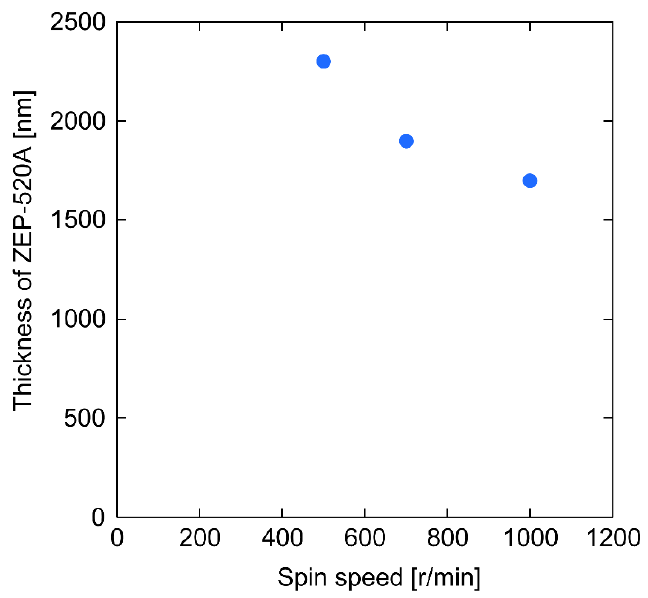
Figure 3. Thickness of spin-coated ZEP-520A with double coating.